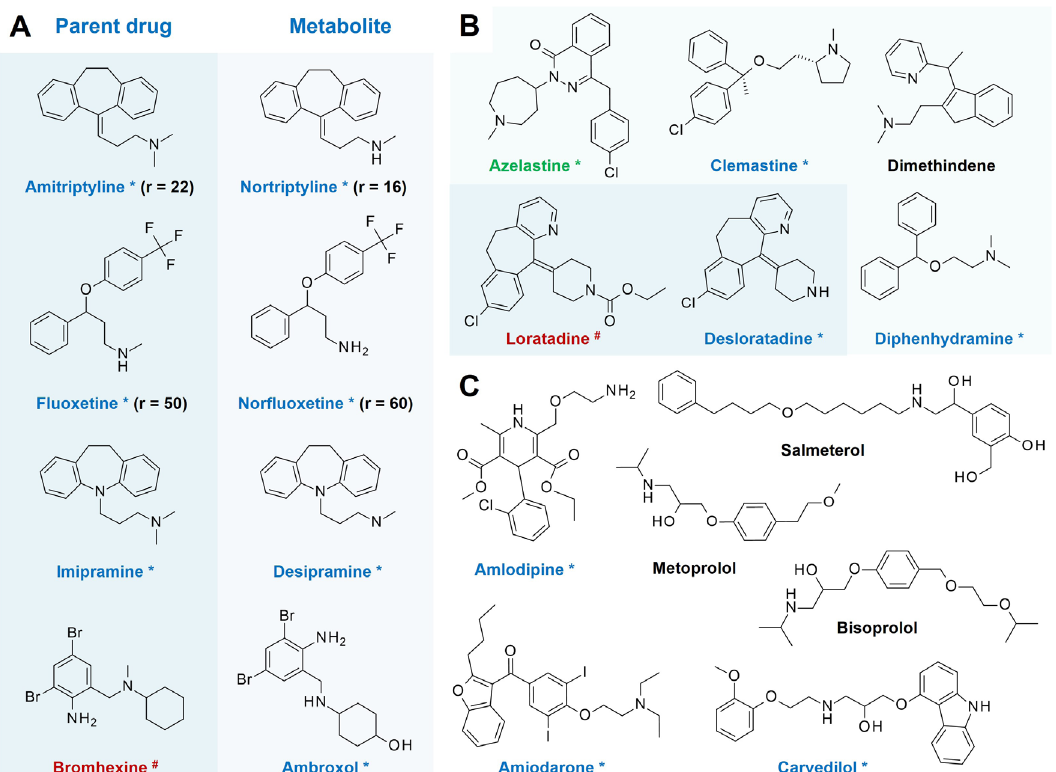
Figure 2. Lysosomotropic drugs, lysosomotropic metabolites as candidates for (systemic) prophylaxis of sepsis, viral infection, and transition to severe SARS-CoV-2 infection/COVID-19. (A) Pairs of confirmed lysosomotropic and non lysosomotropic drugs and their lysosomotropic N -desmethyl metabolites [22, 100, 128–133] and their ratio (r) of pulmonary tissue/plasma concentration, if available. Accumulation in pulmonary tissue is given at a ratio r > 1 [135, 136]; (B) H -antihistamines and candidates for (systemic) 1 prophylaxis of viral infection and transition to severe SARS-CoV-2 infection/COVID-19. Azelastine (*, green) is a nasal and ophthalmic H -antihistamine over-the-counter (OTC) drug with confirmed lysosomotropism and anti-SARS-CoV(-2) efficacy [134]. 1 Bromhexine, ambroxol, loratadine, desloratadine, azelastine, clemastine, dimethindene, and diphenhydramine are likewise OTC drugs and are easily accessible; (C) various commonly used cardiovascular drugs and the bronchodilator salmeterol. Salmeterol (ClogP 3.61) is administered by inhalation and decreases levels of LPS triggered pro-inflammatory cytokines TNF-α, IL-6, and IL-1β [ 137, 138 ] suggesting present lysosomotropism is indicated as confirmed (*, blue), highly probable (black), but yet not confirmed, and no lysosomotropism ( # ,